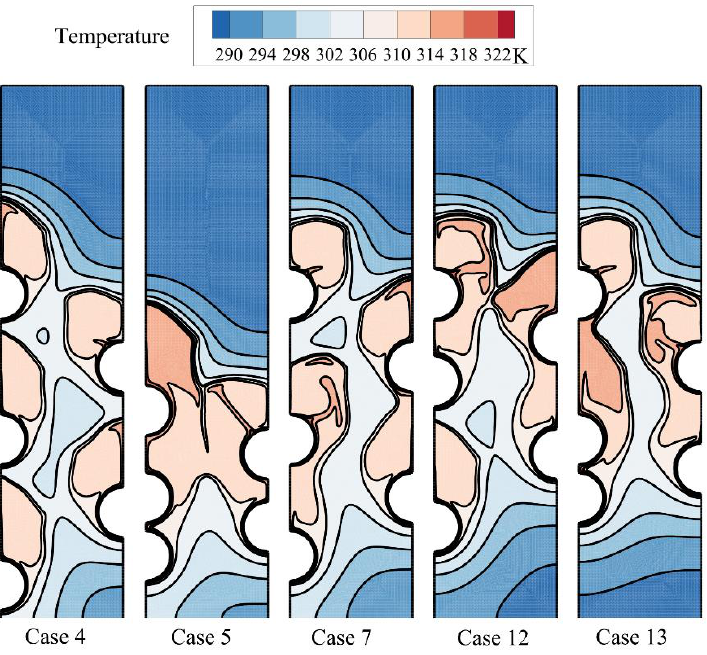
Figure 7. The isotherms for five different arrangements of the tubes after one hour of charging.